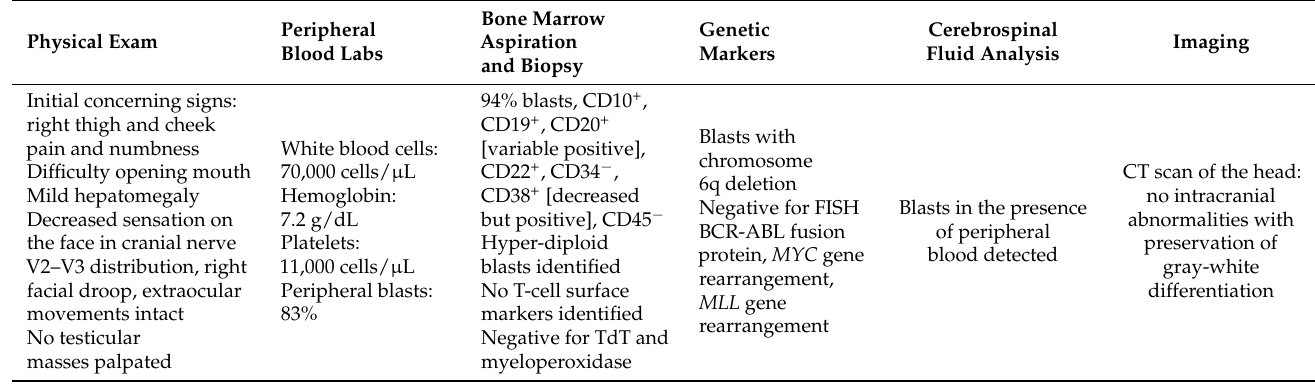
Table 1. Summary of the patient’s clinical characteristics and lab findings upon diagnosis. Abbreviations: CT, computed tomography; FISH, fluorescence in situ hybridization; MLL, mixed lineage leukemia; TdT, terminal deoxynucleotidyl transferase; WBC, white blood